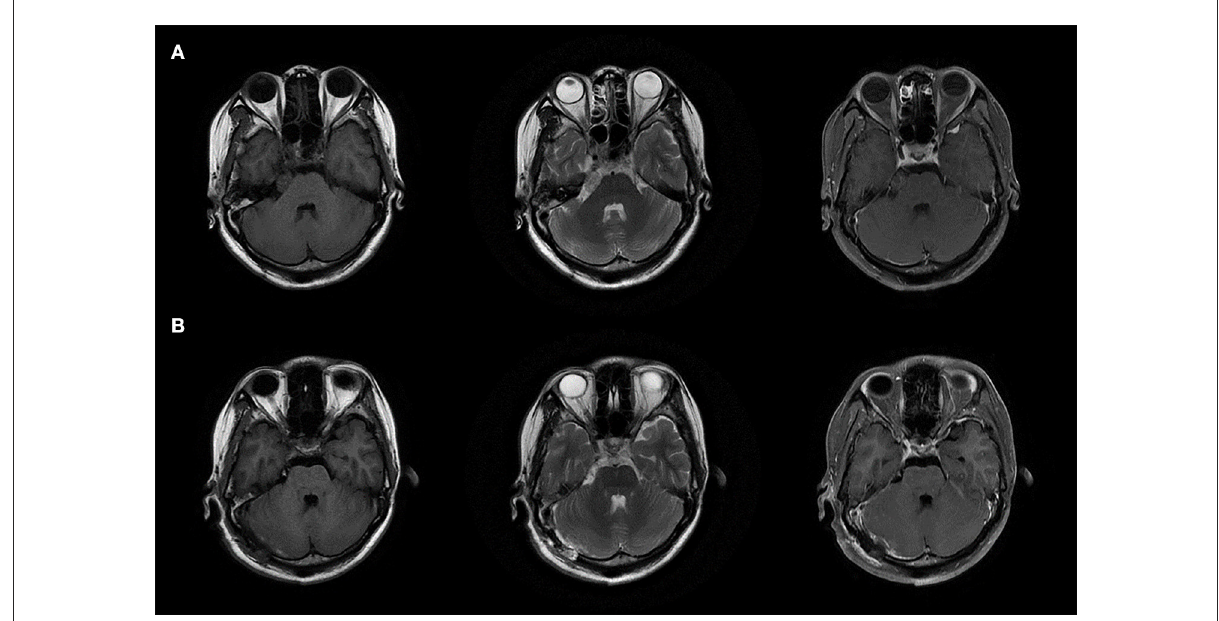
FIGURE1 MRI images of the lesion. (A) Preoperative brain MRI images. (B) Postoperative brain MRI images.